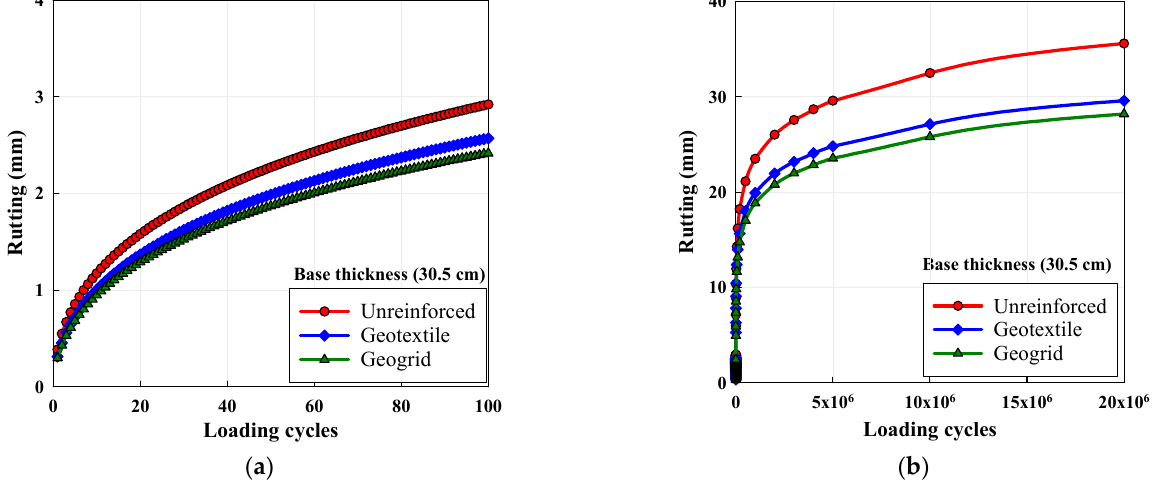
Figure 7. The example of ( a ) calibrated ruttings for 100 cycles and ( b ) extrapolated ruttings.